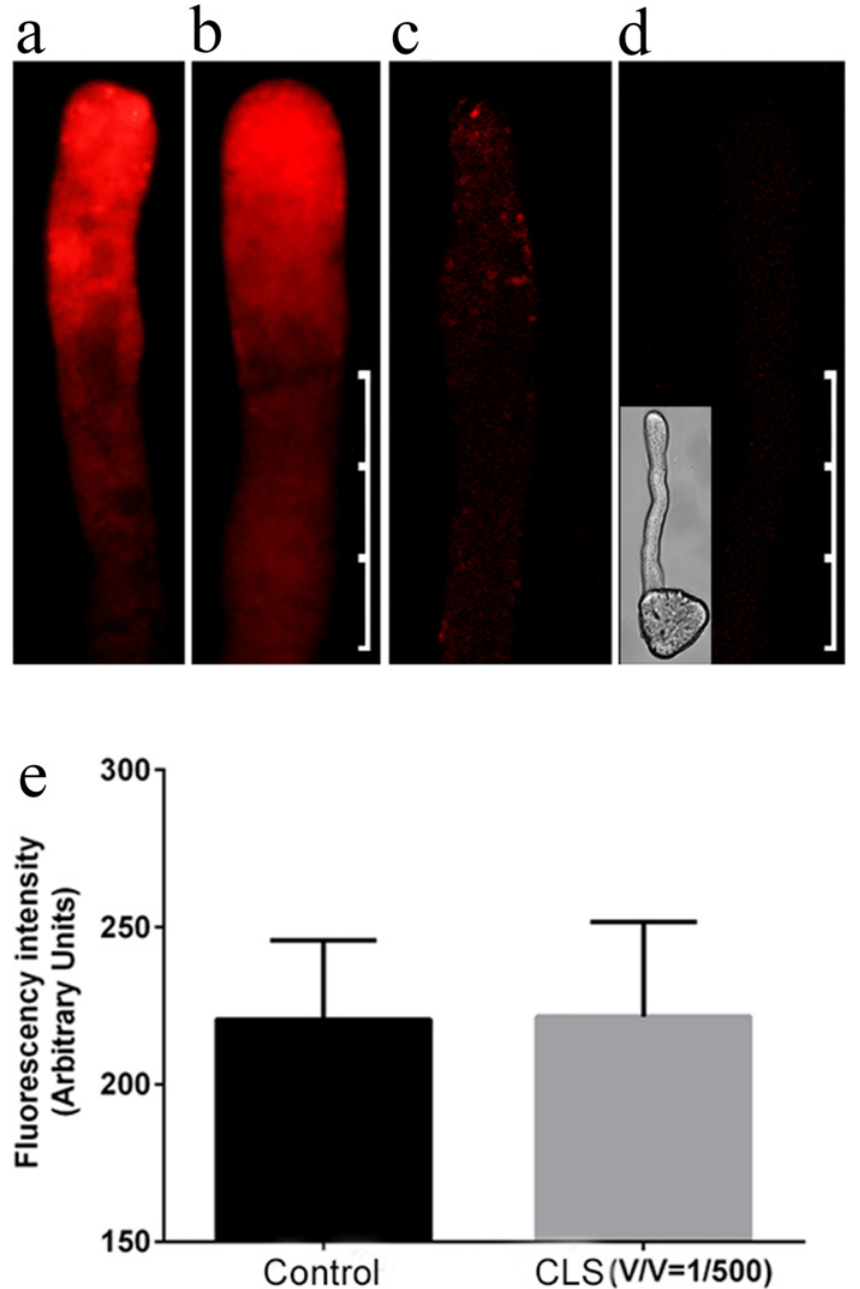
Fig 3. Effect of the cell lysis solution on the pollen tube membranes. (a) Pollen tube dyed with FM4-64 without cell lysis solution (control). (b and d) Pollen tubes after dyeing with FM4-64 for 15 min with 1:500 (v/v) cell lysis solution in the medium (b), with 1:5 (v/v) cell lysis solution in the medium (c) and with 1:1 (v/v) cell lysis solution in the medium (d). (e) Fluorescence value comparison. The difference was not significant. Scale bars: 50 μ m (a and b) and 60 μ m (c and d). Vertical bars indicate ± SE. Each data point represents the mean of three replicates with more than 10 pollen tubes each.